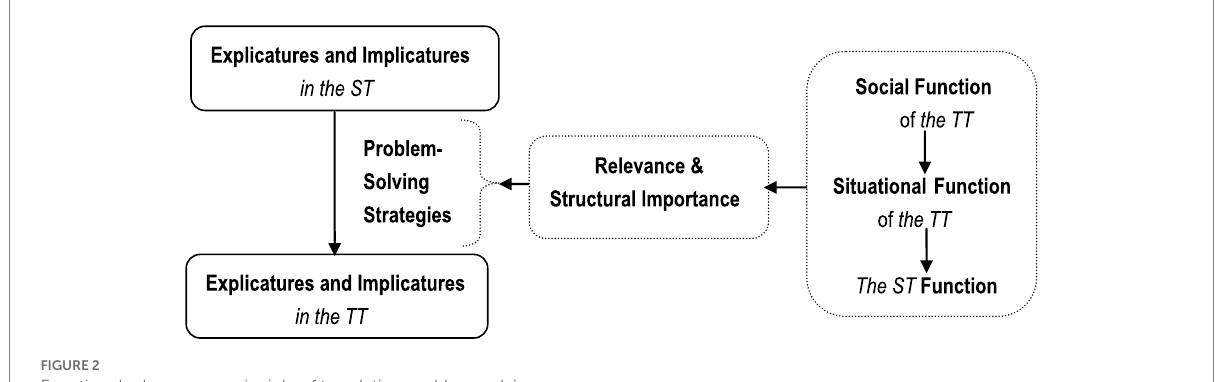
FIGURE 2 Functional relevance as principle of translation